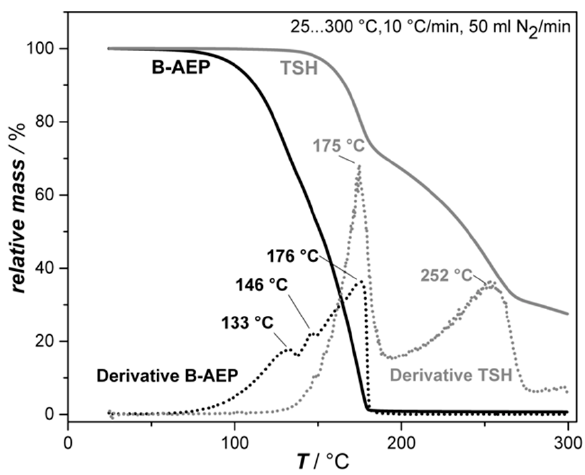
Figure 1. Thermogravimetric analysis (TGA) decomposition curves of B-AEP and TSH.